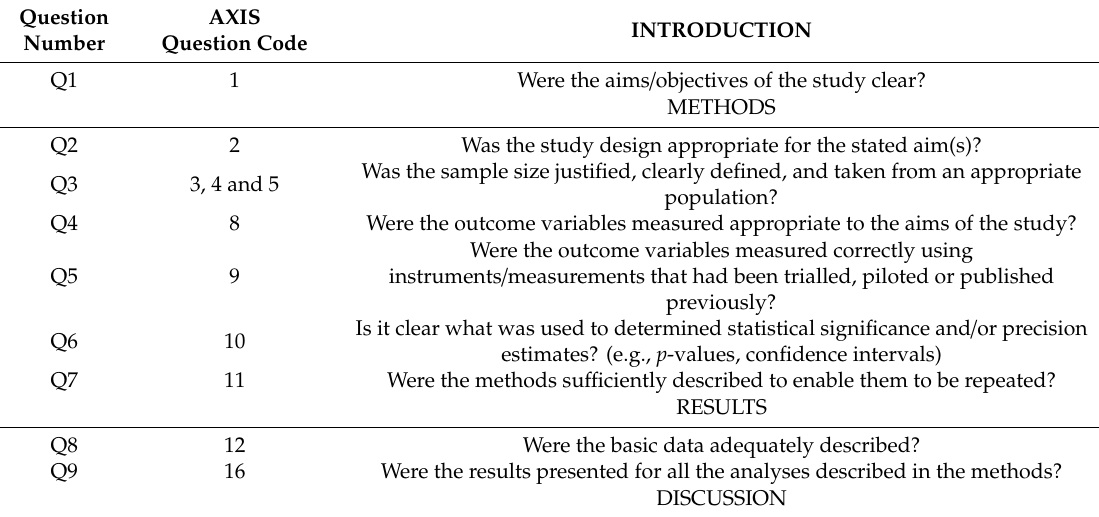
Table 1. Risk and quality assessment questions of the modified AXIS